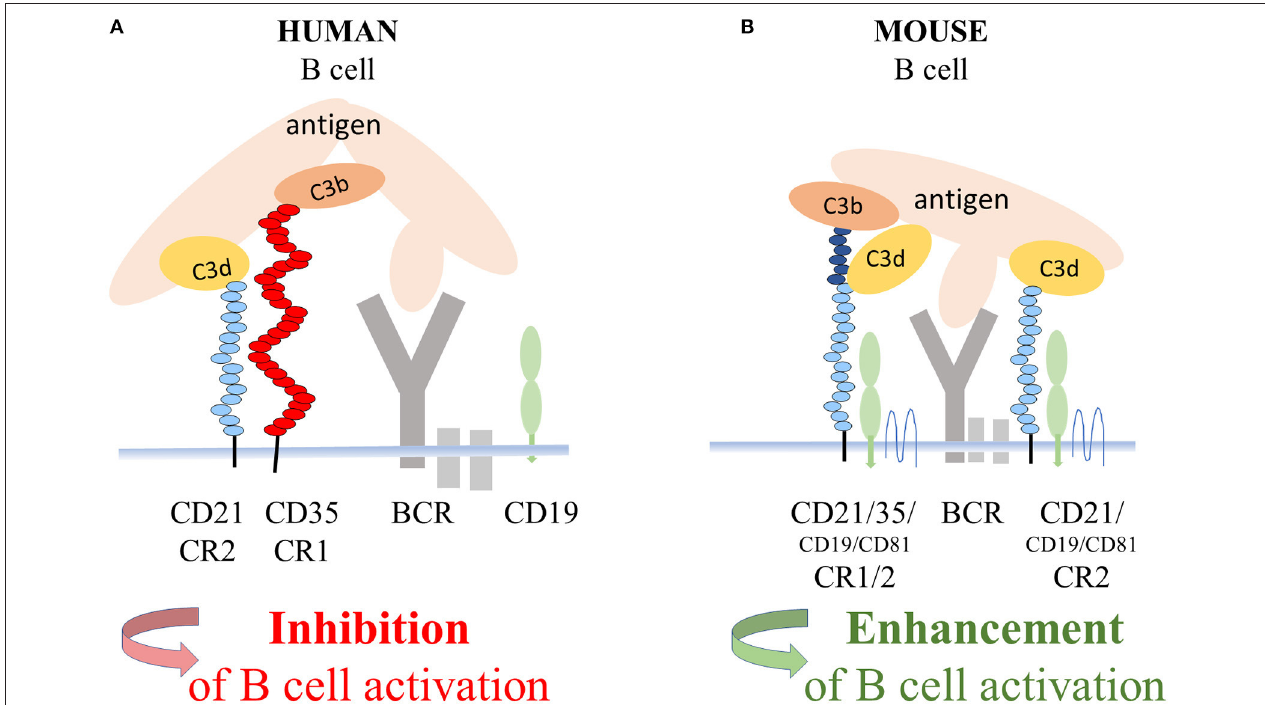
FIGURE 6 | Suggested mechanism of the CD21 mediated inhibition of BCR triggered functions of human B cells. In the coclustered complexes of human CD21 and CD35, from which CD19 is excluded, the strong inhibitory effect of CR1 controls BCR-induced activation (A) . In mice, coclustering BCR and the trimolecular complex containing CD19 and CD81 and the alternatively spliced CR1/2 enhance B-cell activation (B) .